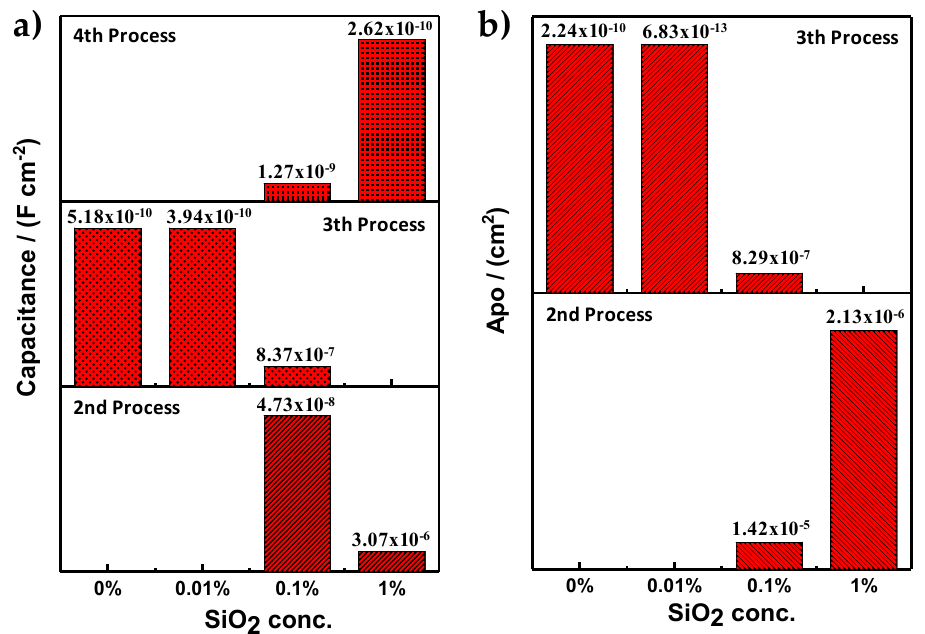
Figure 3. ( a ) Capacitance values and ( b ) porous area for the PMMA and PMMA with di ff erent Figure 3. a ) Capacitance values and b ) porous area for the PMMA and PMMA with different concentrations of SiO 2 concentrations of SiO 2 nanoparticles.